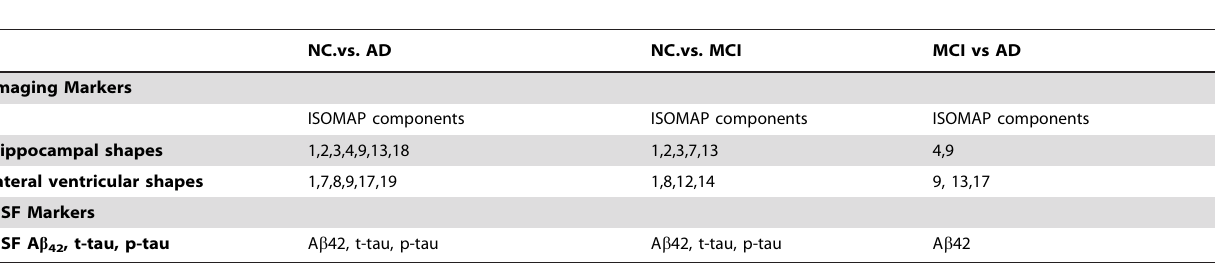
Table 3. ISOMAP components of the hippocampus and lateral ventricles as well as CSF markers contribute to the group differences between normal controls (NC) and subjects with Alzheimer’s disease (AD), NC and subjects with mild cognitive impairment (MCI), and subjects with MCI and